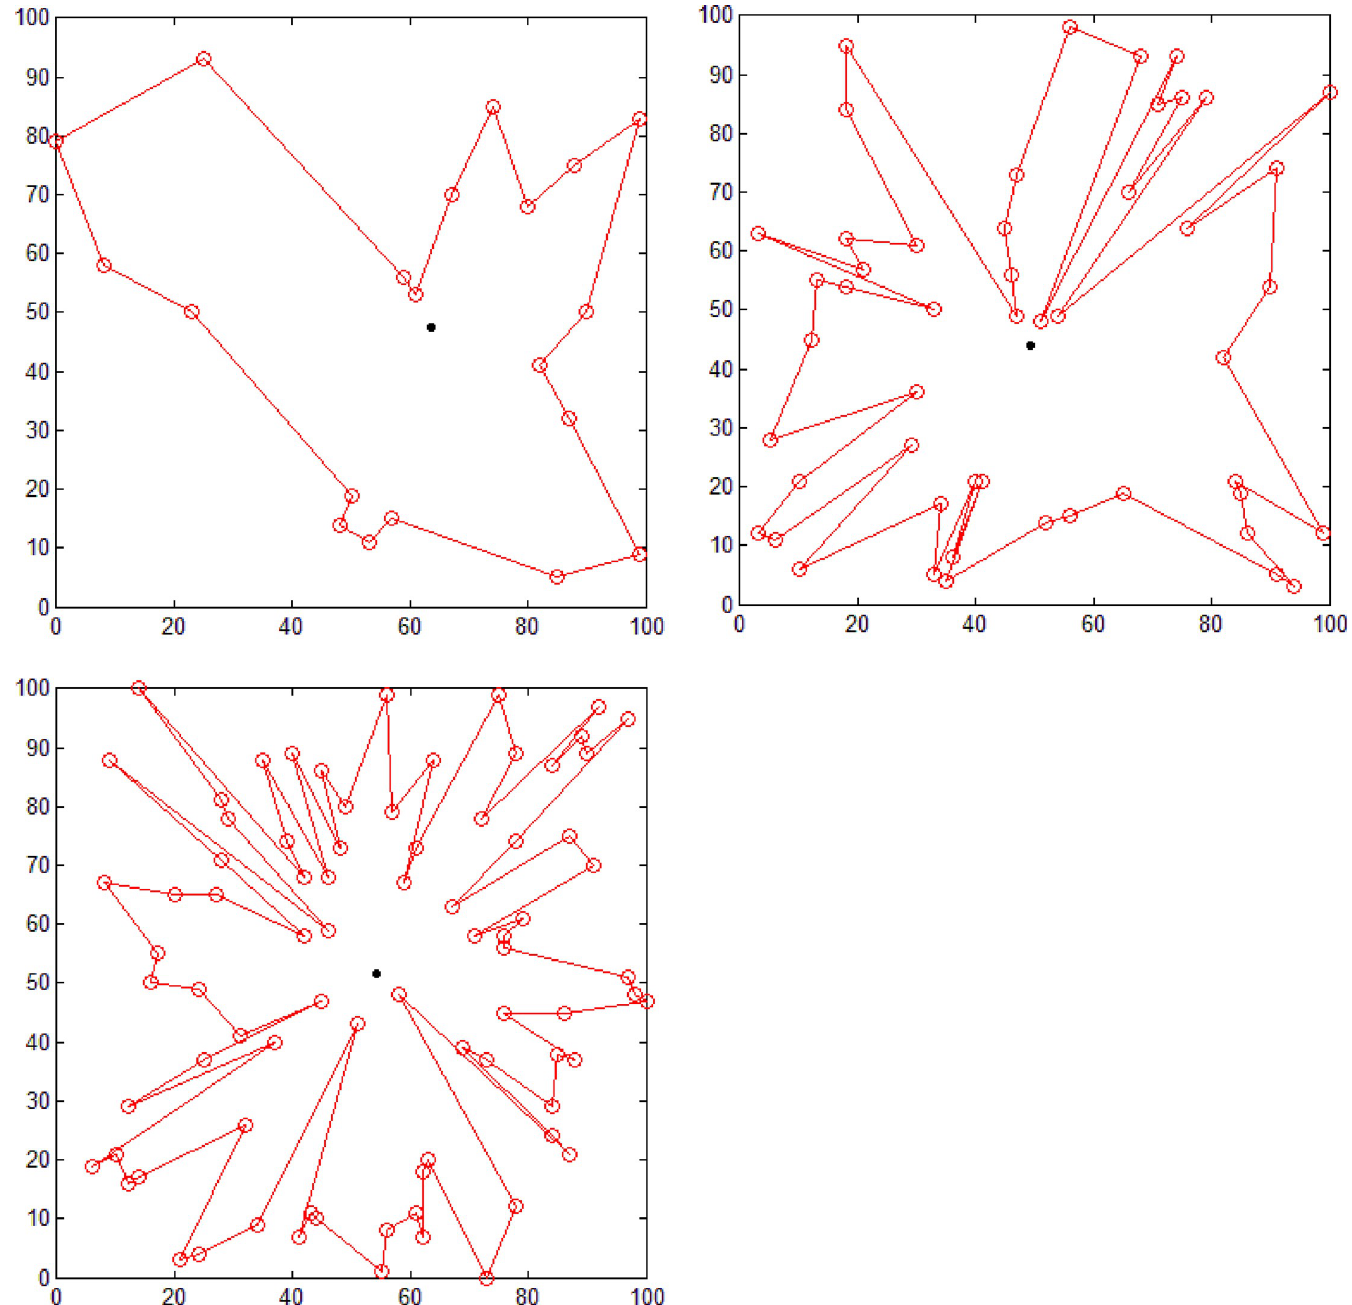
Fig 14. Polygon generation using the polar coordinate sorting method. Polygon consisting of (a) 20 (b) 50, and (c) 80 points.